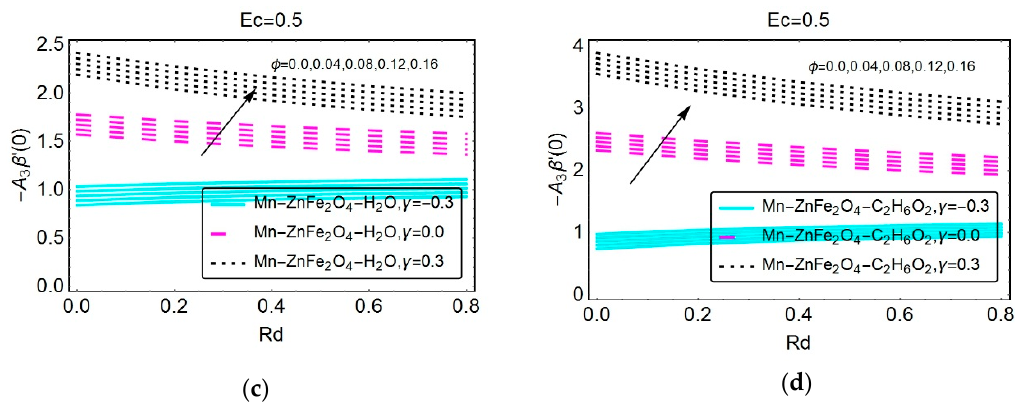
Figure 8. Alterations in the local nusselt number for ( a ) CoFe (cid:2870) O (cid:2872) − H (cid:2870) O ; ( b ) CoFe (cid:2870) O (cid:2872) − C (cid:2870) H (cid:2874) O (cid:2870) ; ( c ) MnZnFe (cid:2870) O (cid:2872) − H (cid:2870) O ; (d) MnZnFe (cid:2870) O (cid:2872) − C (cid:2870) H (cid:2874) O (cid:2870) nanofluids by varying 𝜙 .